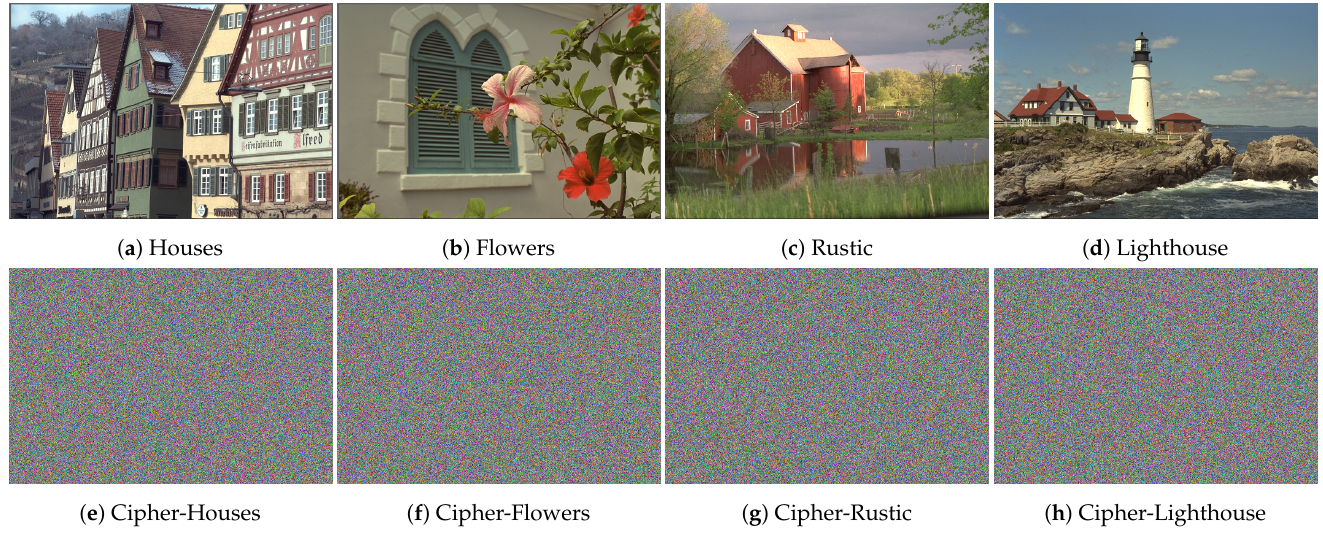
Figure 3. Image dataset utilized for evaluating the proposed cryptosystem ( a – d ) and its corresponding ciphered ones ( e – h